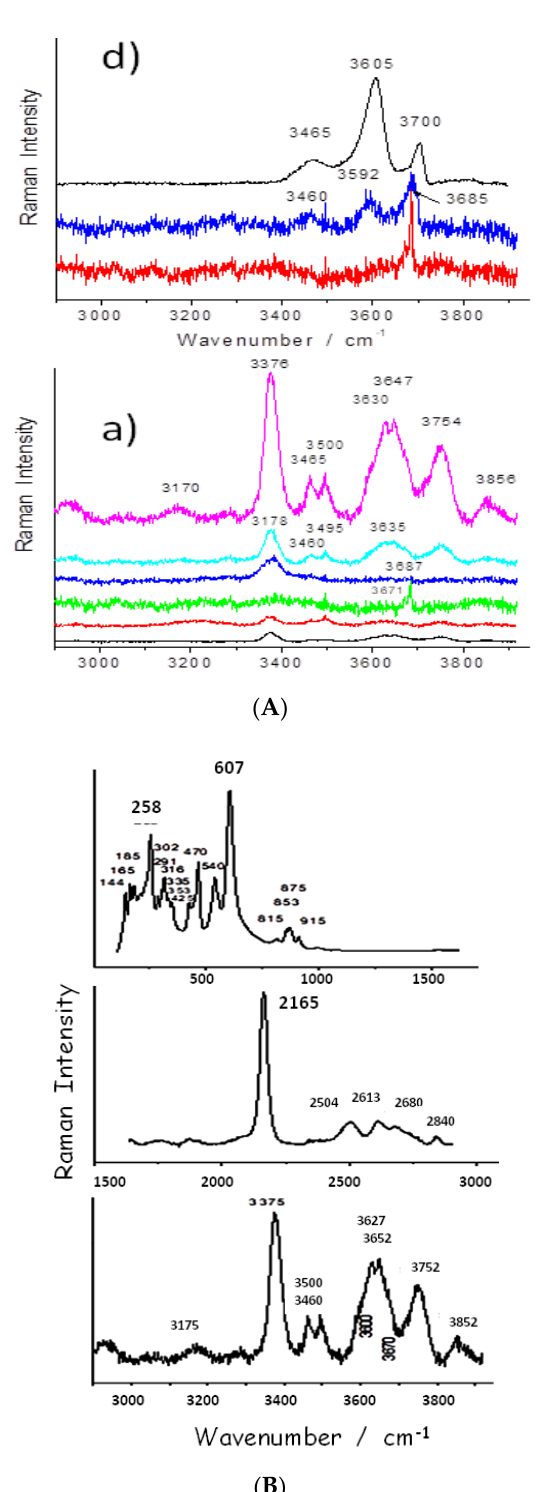
Figure 9. Representative Raman spectra recorded in the 2900–3950 cm −1 range on samples a and d ( A , above, see Figure 1). Examples of untransformed grain core are given on the top spectra. Maximum intensity is measured in the center of the biggest grains visible on the cross-section. Details for the spectrum of sample a are given on the bottom ( B ).